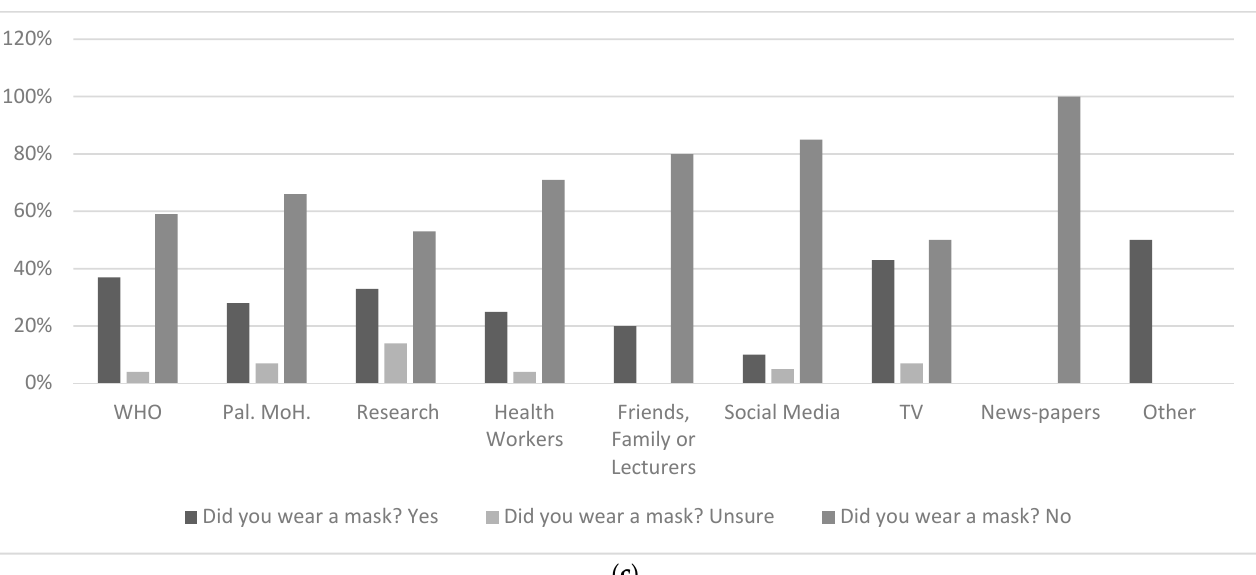
Figure 4. Information-seeking strategies and COVID-19-related practices: ( a ) general behaviors, ( b ) socialization patterns, and ( c ) wearing masks.